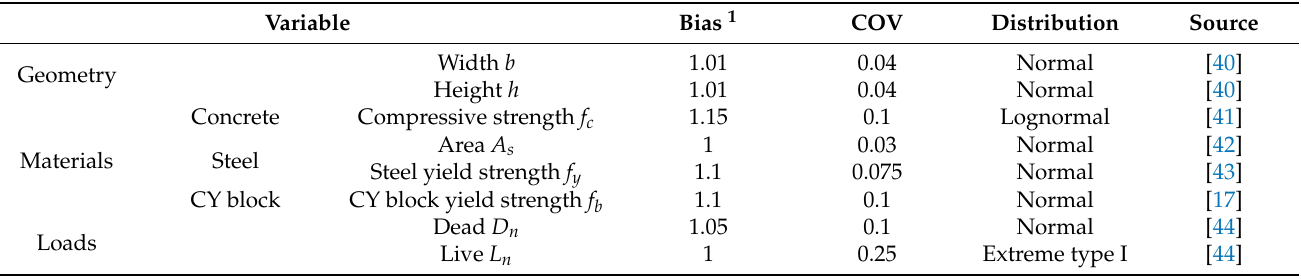
Table 3. Probabilistic characteristics of resistance design variables and